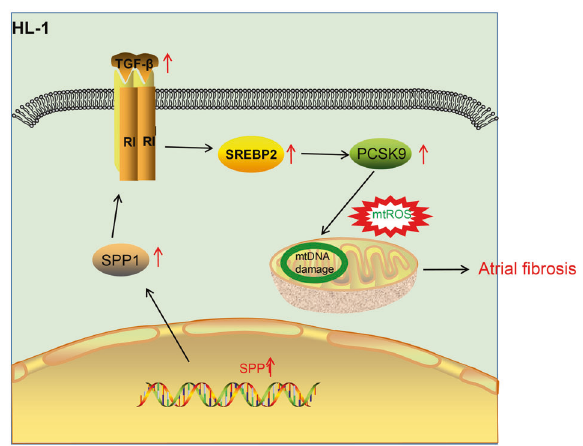
Fig. 8 Molecular mechanism underlying the role of SPP1 in atrial fi brosis. SPP1 activates the TGF- β /SREBP2 signaling pathway, thus elevating the expression of PCSK9. By this mechanism, the mtDNA damage is induced and the subsequent atrial fi brosis is ultimately